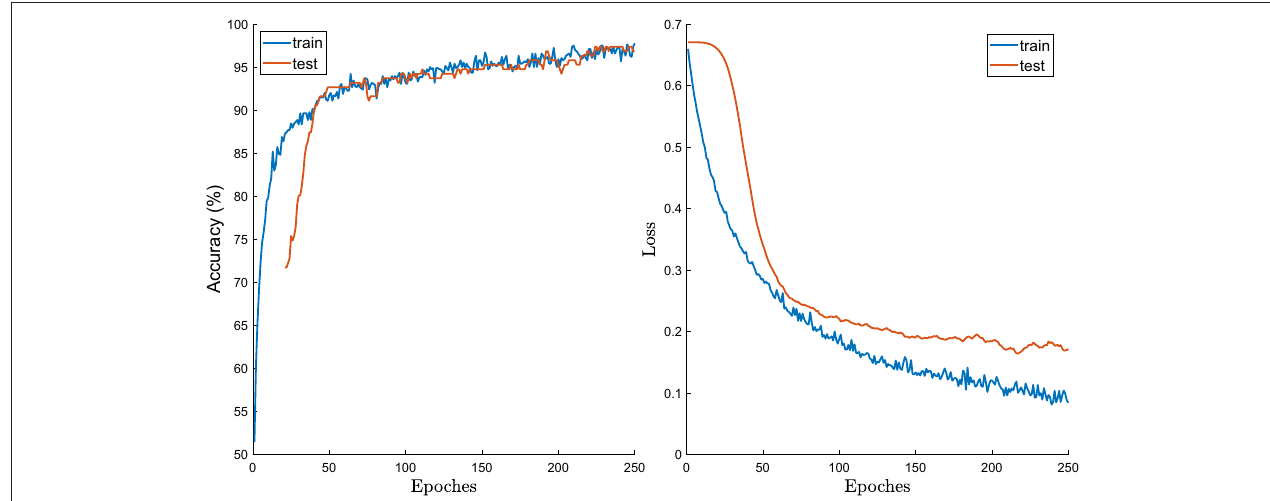
FIGURE 4 | Example of the training procedure for a neural network run. Left : Accuracy vs. number of epoches. Right : cross-entropy loss vs. number of epoches. The results were stabilized for an epoch number of ∼ 250. Blue lines show the behavior of the training subset while orange lines show that of the testing subset.